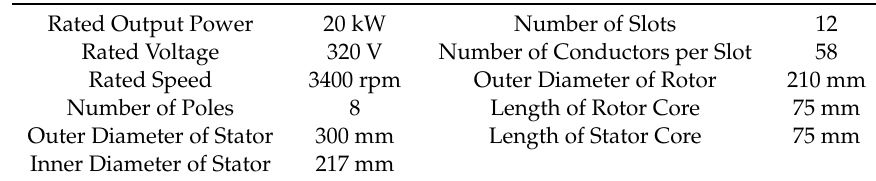
Table 2. Magnetic parameters to validate the analytical calculation of reluctance torque for IPMSM. Table 1. Machine parameters for validation of the analytical calculation of reluctance torque for permanent magnet excited synchronous machines with interior magnets (IPMSM).